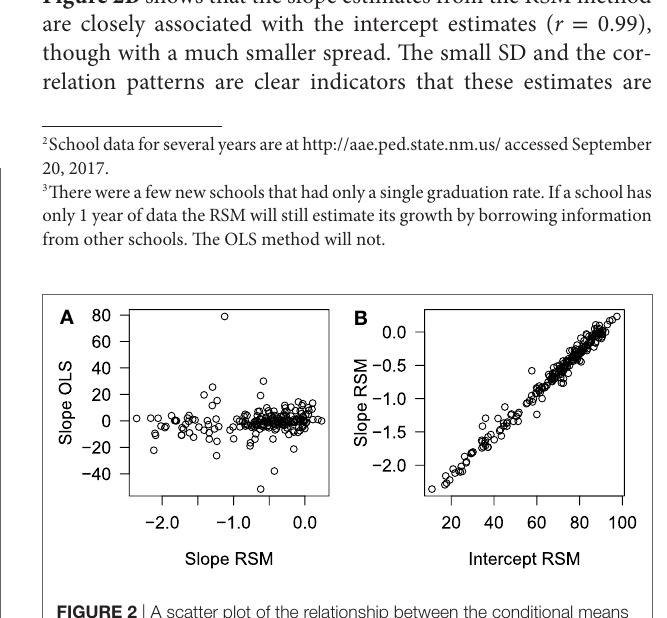
FIGURe 2 | A scatter plot of the relationship between the conditional means for the intercept and for the slope. (A) Slope RSM and (B) intercept RSM.